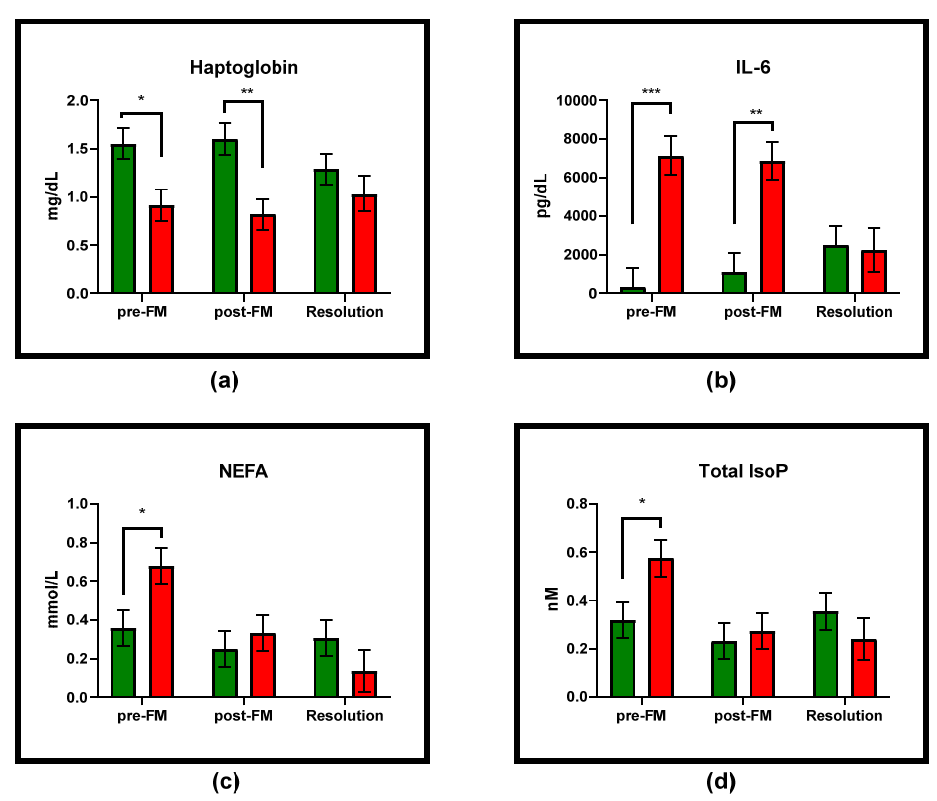
Figure 1. Concentrations (mean ± SEM) of blood biomarkers that differed between the infection outcome groups (green bars = survived; red bars = died) at any of the sampling timepoints: ( a ) haptoglobin was elevated among cows that survived pre- and post-FM treatment, but was not different between outcome groups at resolution; ( b ) IL-6 was elevated pre- and post-FM treatment among cows that died, but was not different between outcome groups at resolution; ( c ) NEFAs were elevated pre-FM treatment among cows that died, but not post-FM treatment or at resolution; ( d ) total IsoP pre-FM treatment were elevated among cows that died, but not post-FM treatment or at resolution. * p < 0.05, ** p < 0.01, and *** p < 0.001. Table 1. Blood biomarkers of oxidant status over the course of systemic coliform mastitis with FM treatment in Holstein cows.